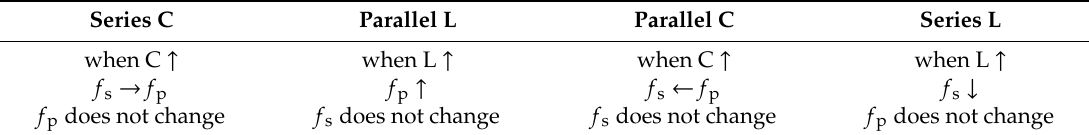
Table 3. Impact of adding capacitors and inductors to BAW